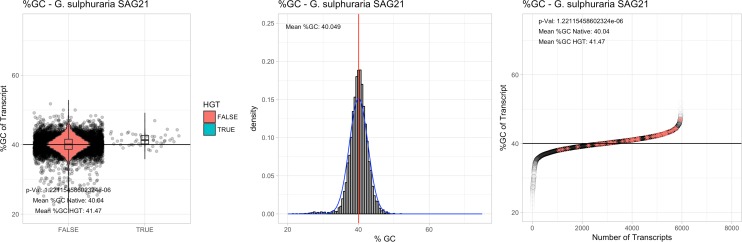
%GC – Galdieria sulphuraria SAG21: (Left) Violin plot showing the %GC distribution across native transcripts and HGT candidates.(Mid) Cumulative %GC distribution of transcripts. Red line shows the average, blue line a normal distribution based on the average value. (Right) Ranking all transcripts based upon their %GC content. Red ‘*' demarks HGT candidates. As the %GC content was normally distributed, students test was applied for the determination of significant differences between the native gene and the HGT candidate subset.